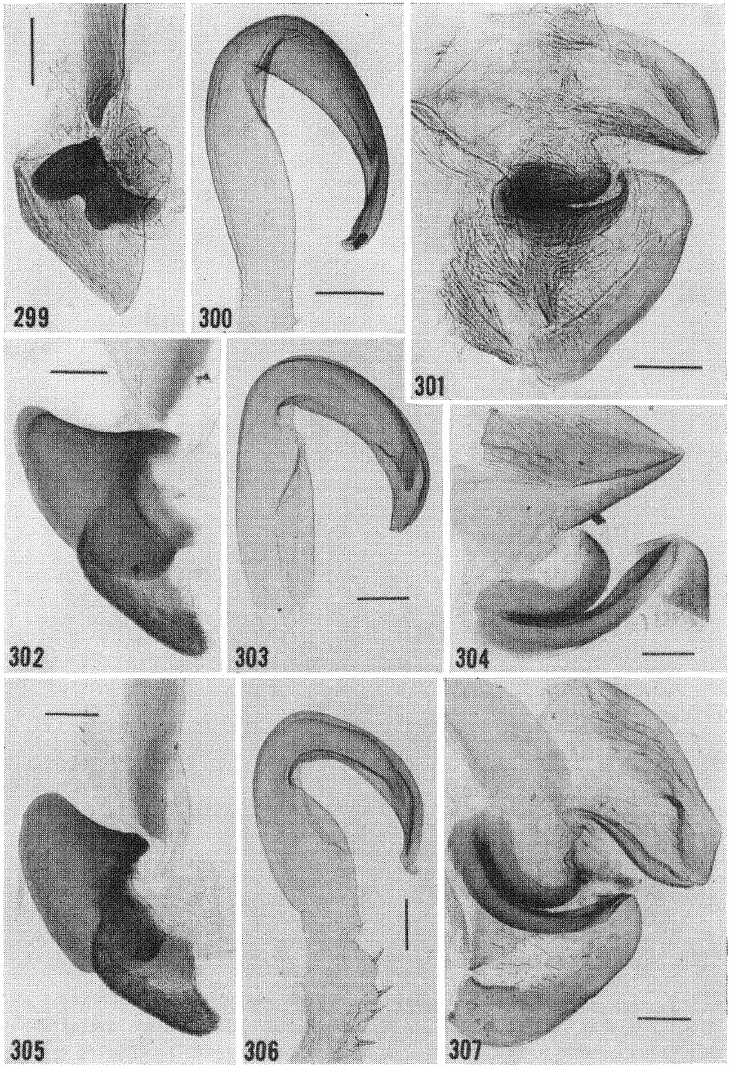
Figs. 299-307. Cockroach male genitalia. 299-301. (25 MCZ). Ep’lampra latifrons. Pernambuco, Brazil. (det. Rehn). 302-307. E#ilampra heusseriana. 302-304. (151 USNM). Cerro Montevideo. (det. Albuquerque). 305-307. (160 USNM). Rio Grande da Sul, Brazil (det. Roth).